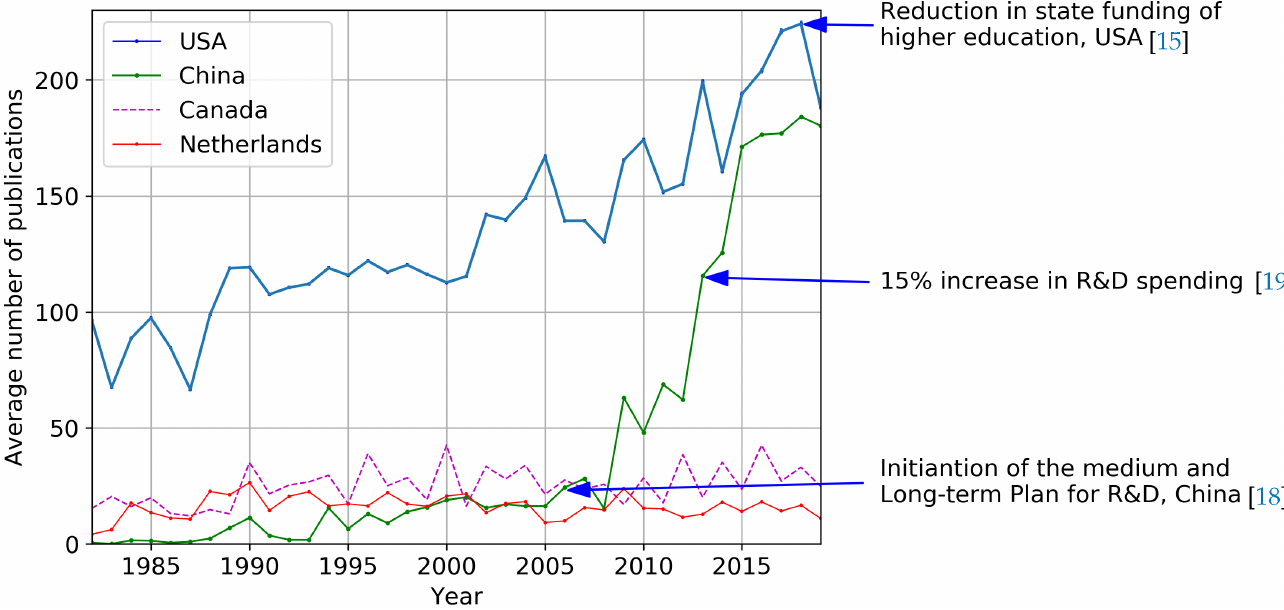
Figure 6. Average number of publications by academia from the top four contributing countries. Data sources: [15,18,19].